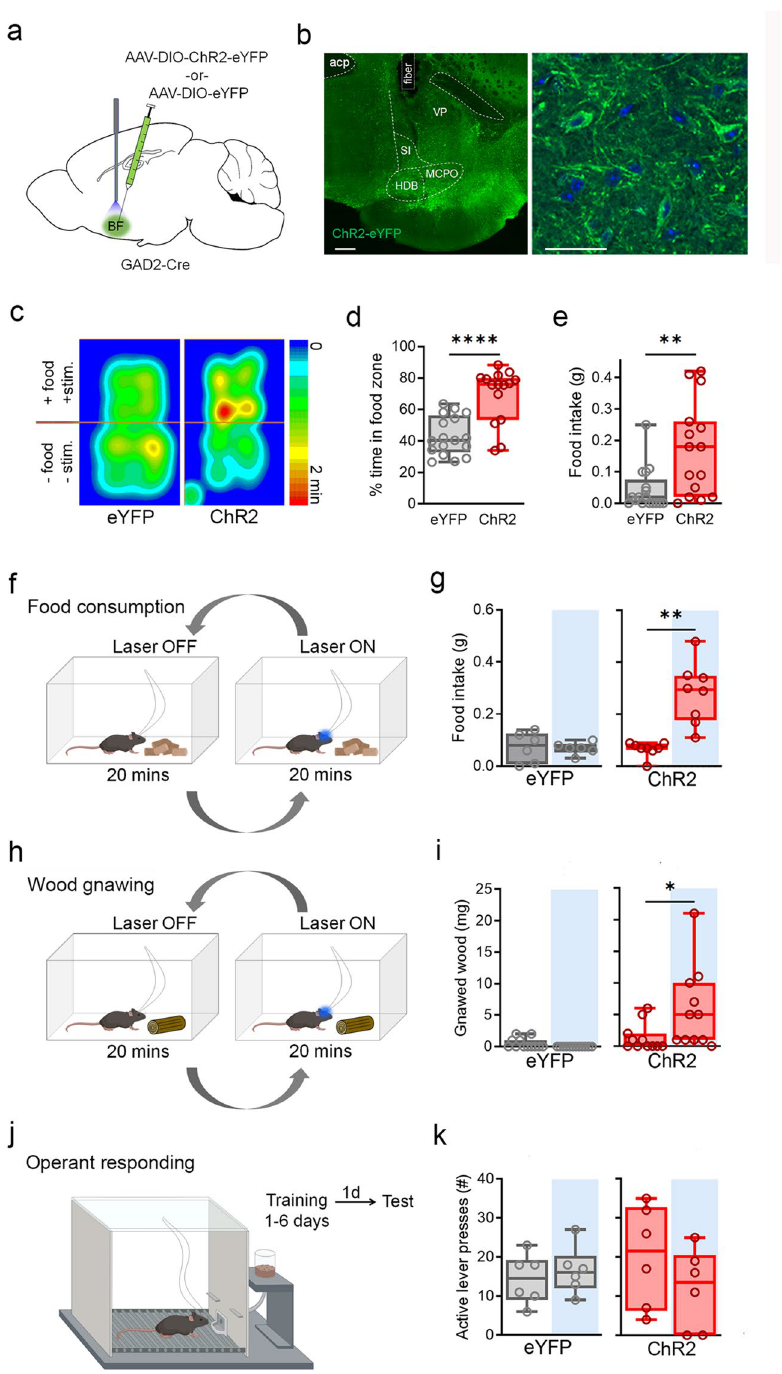
Figure 1. Activation of BF GAD2+ neurons increases consummatory drive. ( a ) Stereotaxic targeting of viral vectors and optogenetic stimulation. ( b ) Confocal image of viral expression and optic fiber placement in BF, 200 µm scale bar. Right panel, high power inset of ChR2-expressing neurons in BF, 50 µm scale bar. Blue channel: 4 ′ ,6-diamidino-2-phenylindole (DAPI). ( c ) Heatmap of center body location, mean of eYFP and ChR2 groups, during test of food exposure paired with optic stimulation. One side of the arena contained food pellets, whereupon entry triggered optic stimulation. ( d ) Percent time spent in food zone. Mann–Whitney test, U = 36, ***p < 0.001. ChR2, n = 15; eYFP, n = 17. ( e ) Food intake, ingested mass. Mann–Whitney test, U = 54.5, **p < 0.01. ChR2, n = 15; eYFP n = 17. ( f ) Design for food consumption assay: food biscuits were place at the bottom of the behavioral box and food intake was measured in the presence and absence of laser stimulation, in a counterbalance fashion. ( g ) Food intake, ingested mass during laser OFF and laser ON epochs. Wilcoxon signed rank test, W = 36, **p < 0.01. ChR2, n = 8; eYFP n = 6. ( h ) Design for test of wood gnawing behavior, wherein animals were exposed to a willow tree branch with and without laser stimulation, in a counterbalanced fashion. ( i ) Amount of wood removed due to gnawing during laser ON vs laser OFF epochs. ChR2, Wilcoxon signed rank test, W = 44, *p < 0.05. ChR2, n = 11; eYFP, n = 12. ( j ) Design of test for operant responding for food. Task entails discrimination between two levers, only one of which upon pressing will result in food delivery. ( k ) Active lever presses during laser ON vs laser OFF epochs. ChR2, n = 6; eYFP, n = 6. Schematics ( a , f , h , j ) were created using BioRender.com and